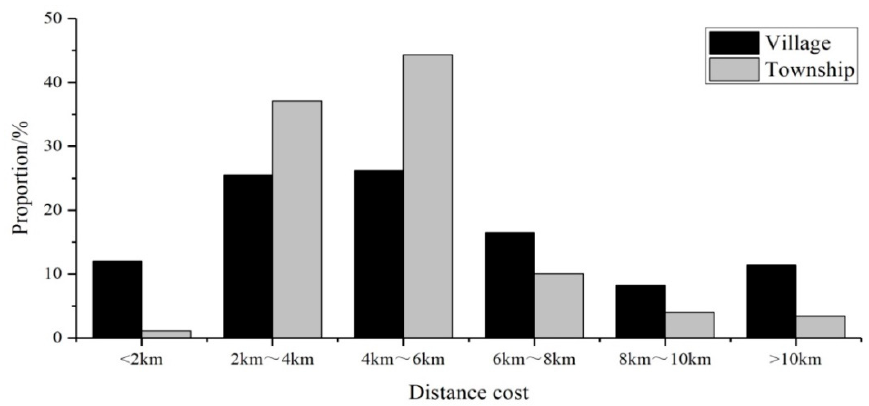
Figure 2. Distribution of distance cost of medical treatment in rural areas of Henan Province.